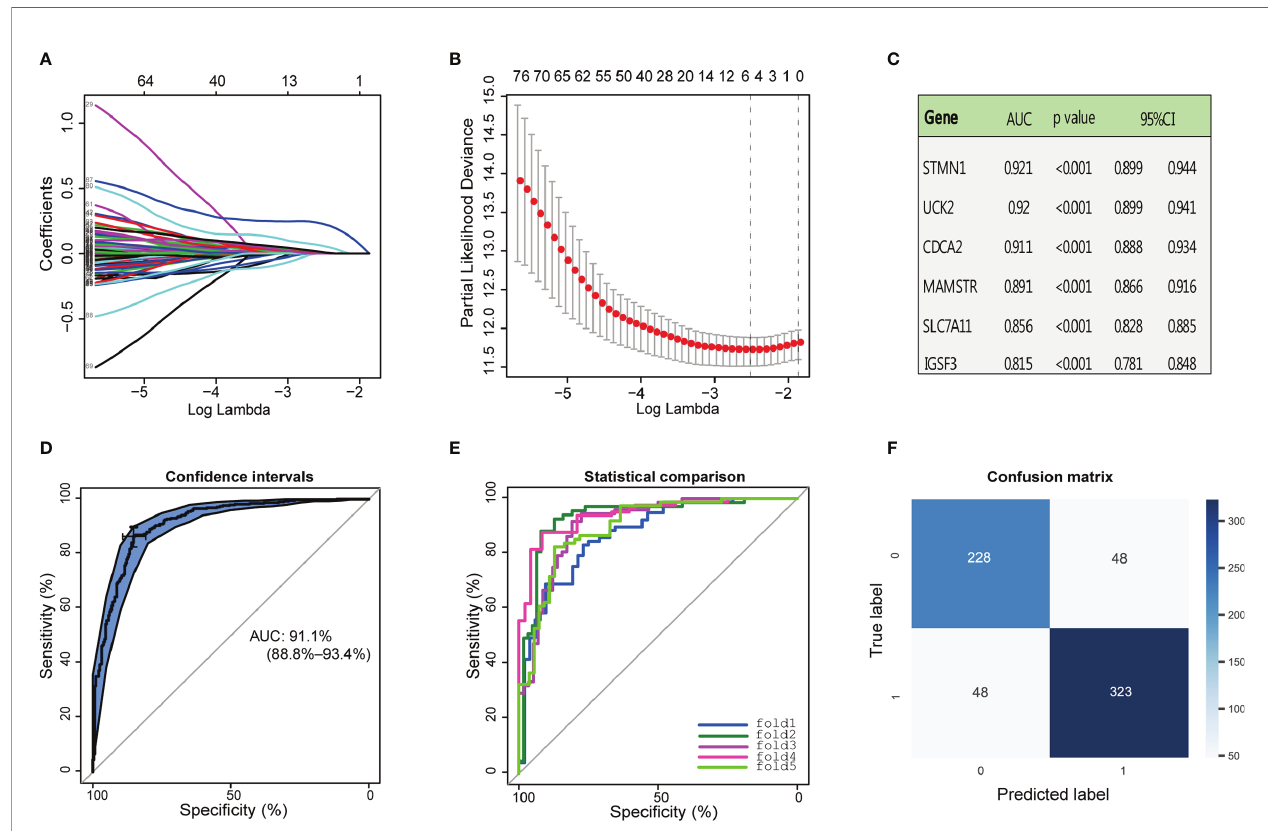
FIGURE 2 | Identi fi cation of cell division cycle associated 2 (CDCA2). (A, B) Least absolute shrinkage and selection operator (LASSO) Cox regression analysis was performed with the expression pro fi les of 96 genes and survival information in The Cancer Genome Atlas (TCGA) cases, and six major prognosis-related genes were obtained. (C) The area under the curve (AUC), 95% CI, and p-values for the above six genes as diagnostic markers of hepatocellular carcinoma (HCC) were calculated in the combined Genotype-Tissue Expression (GTEx) and TCGA data. (D) Receiver operating characteristic (ROC) curve analysis was used to assess the sensitivity and speci fi city of CDCA2 as the marker gene of HCC. (E) Sensitivity and speci fi city regarding the diagnostic ef fi cacy of CDCA2 for HCC in each fold data from the 5-fold cross-validation. (F) Confusion matrix showed that the model constructed with CDCA2 successfully predicted 228 healthy cases and 323 HCC